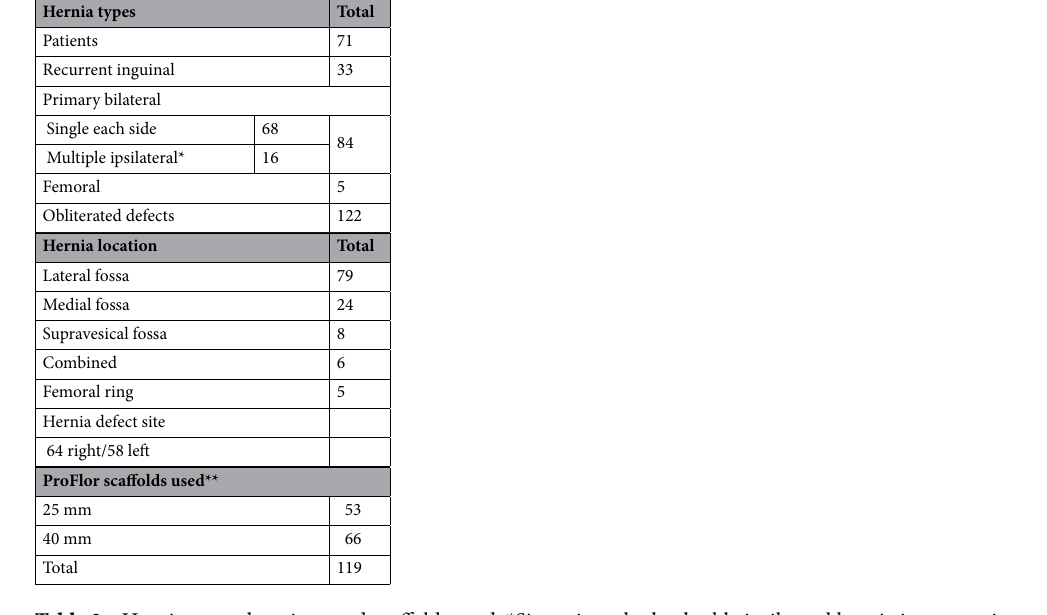
Table 2. Hernia types, locations and scaffolds used. *Six patients had a double ipsilateral hernia in one groin and two other patients presented with double bilateral ipsilateral hernias. **Three double ipsilateral hernias were repaired with a single unit of 40 mm ProFlor by side dislocation of the septal arrangement dividing the two defects (septum